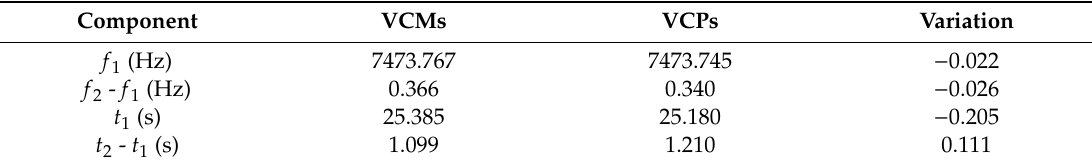
Table 4. Results and comparisons between the VCMs and the VCPs.